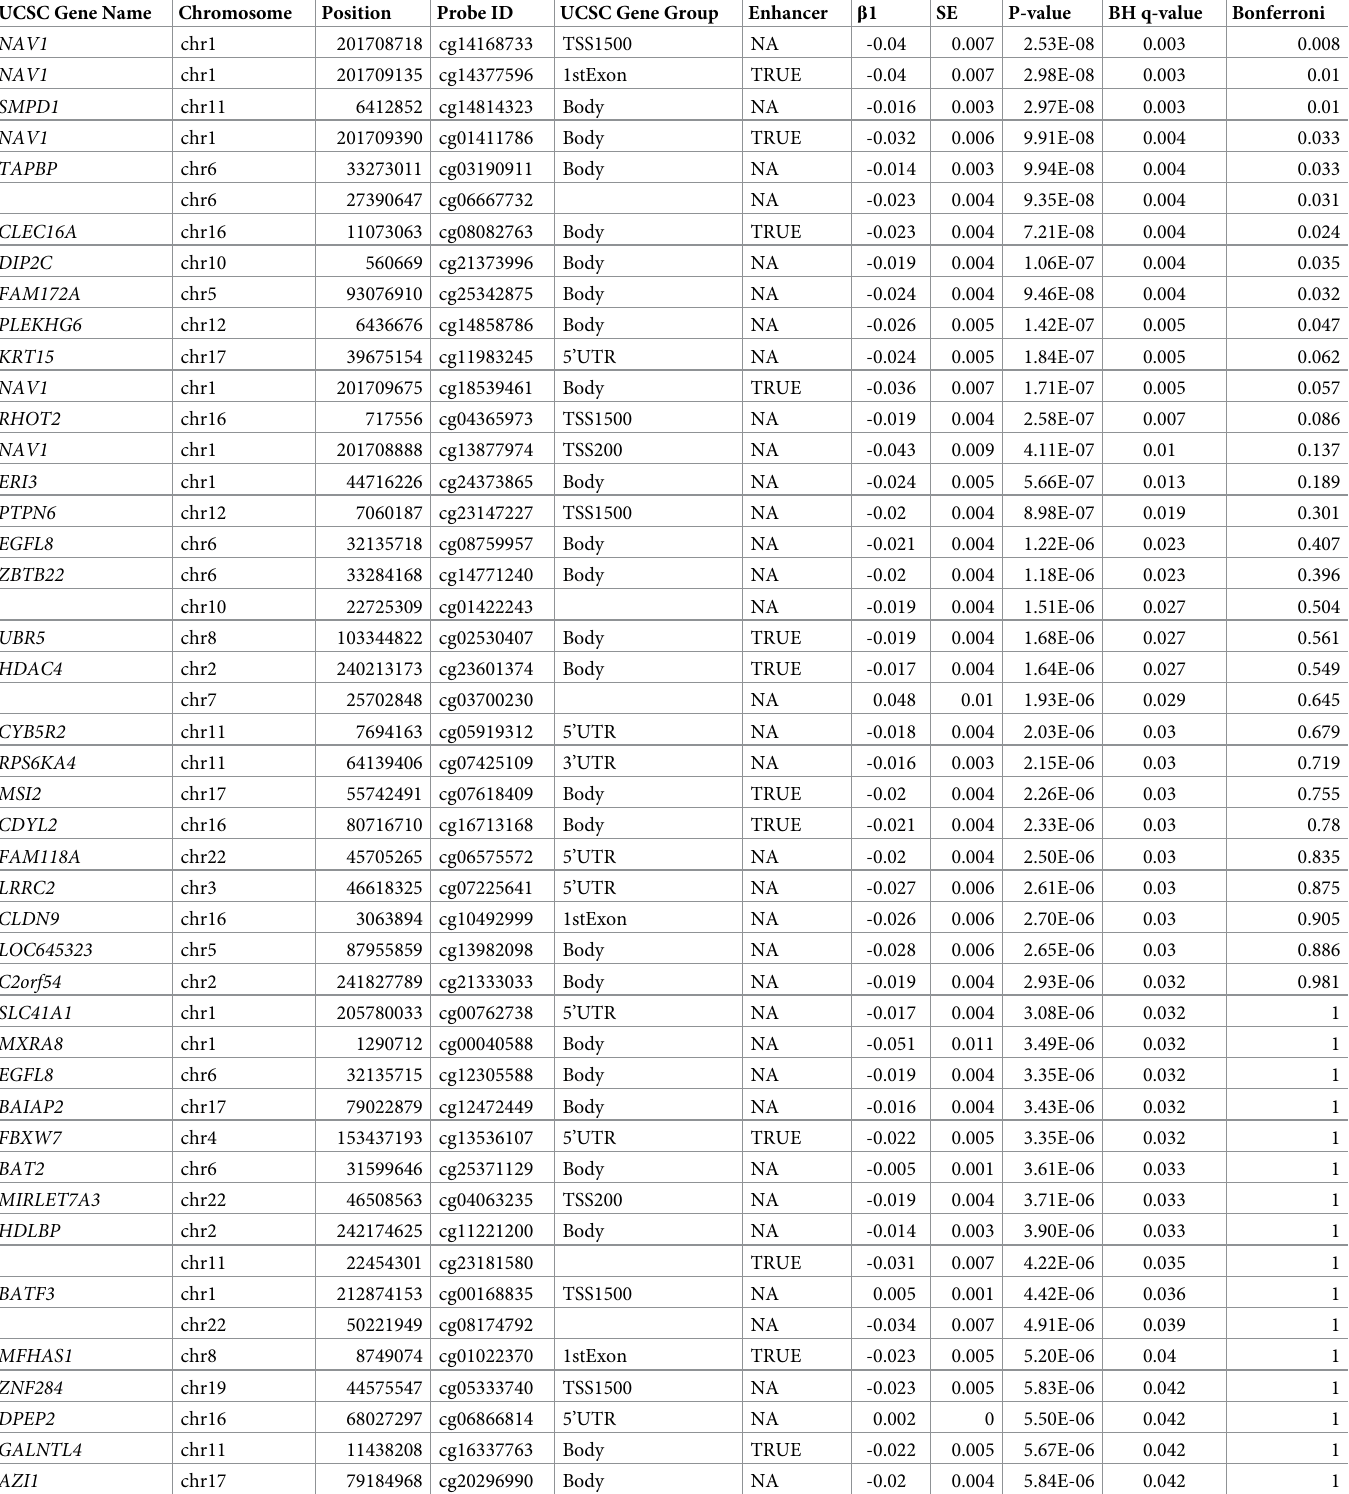
Table 2. List of differentially methylated CpG sites in night shift workers compared to non-night shift workers after epigenome-wide analysis (BH q < 0.05). UCSC Gene